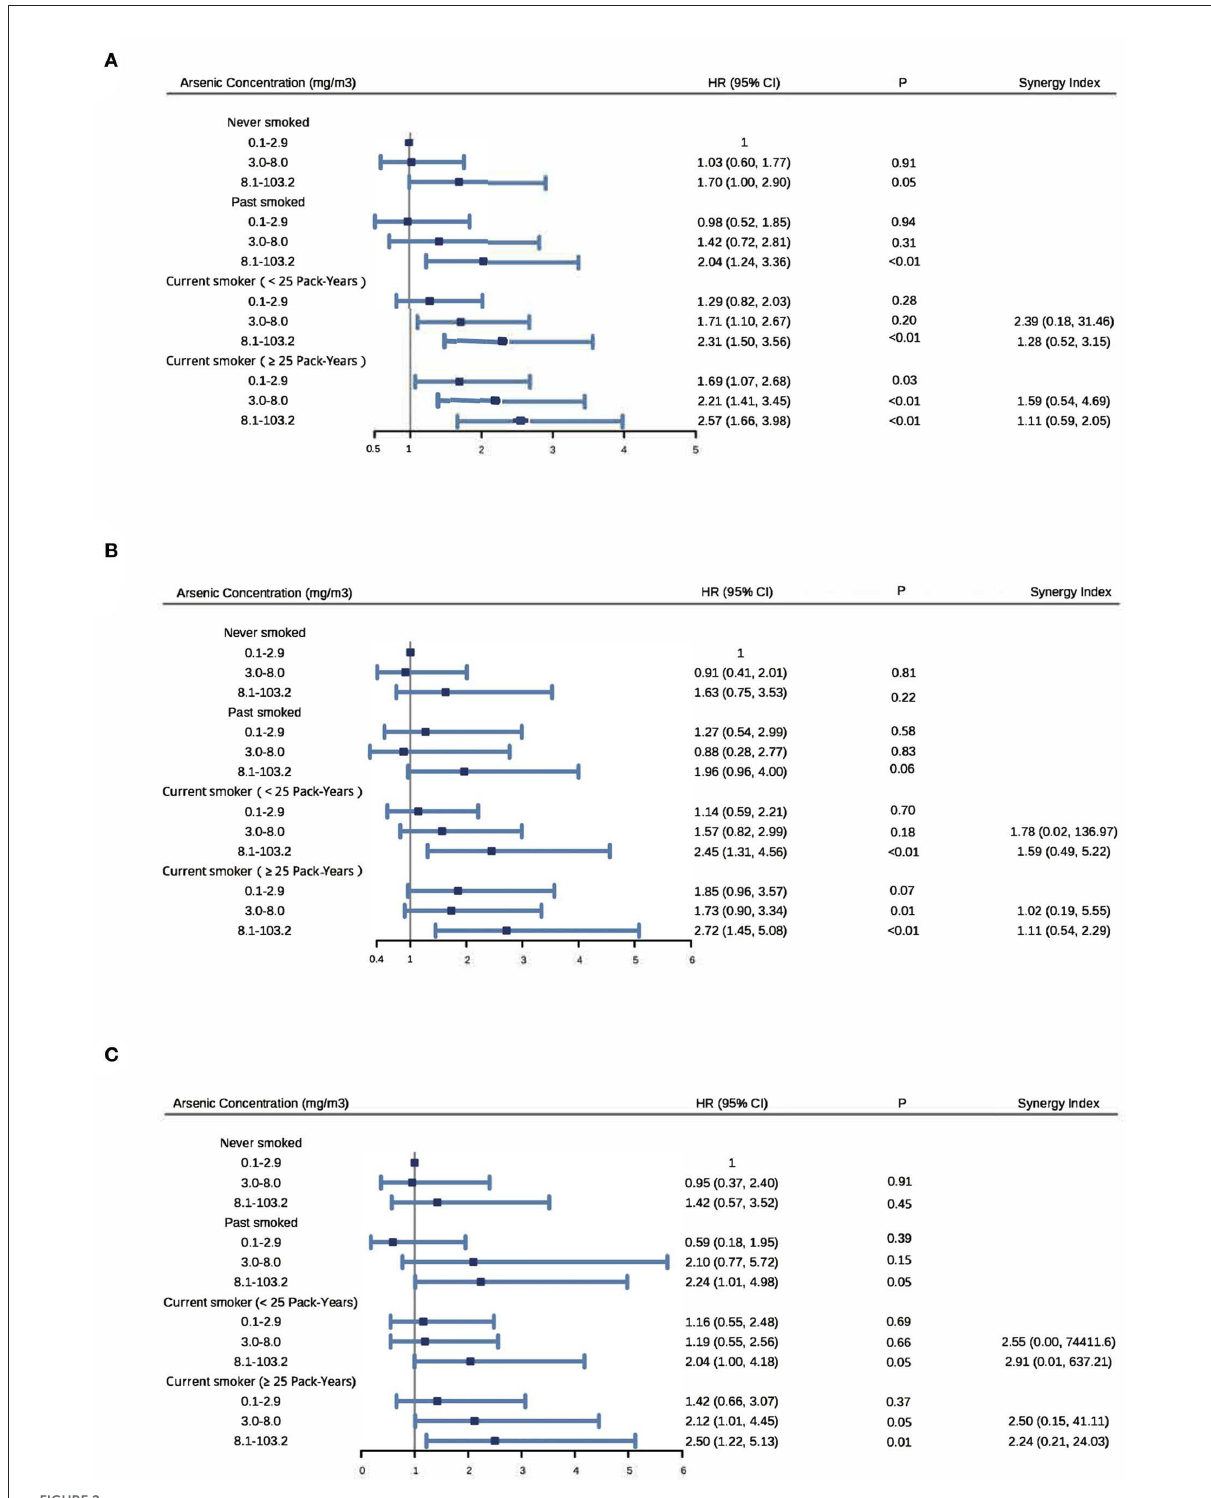
FIGURE2 Synergy between arsenic exposure and cigarette smoking on cardiovascular disease (A) , cerebrovascular disease (B) and heart disease (C) mortality. Adjusting for sex and baseline age groups (5-years), radon, BMI and educational level (never, primary school and middle school or above). Participants were equally divided into three subgroups by arsenic concentration: 2,455 in 0.1–2.9 mg/m 3 , 2,696 in 3.0–8.0 mg/m 3 and 2,584 in 8.1–100.2 mg/m 3 . Among current smokers, they were divided into two subgroups by the median of 25